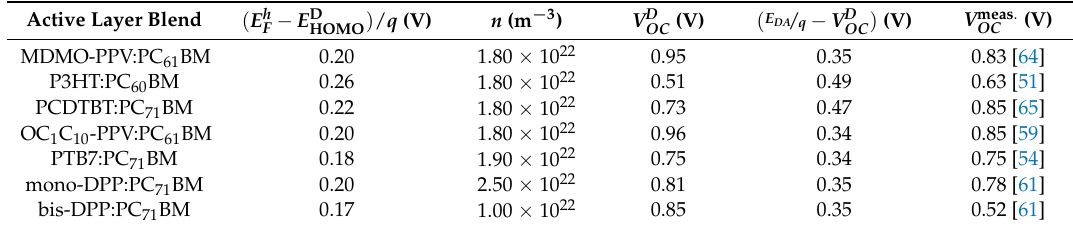
) for comparison OC . OC